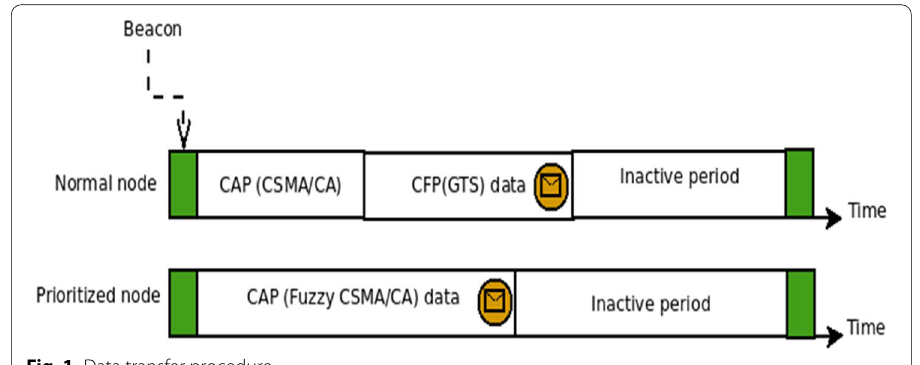
Fig. 1 Data transfer